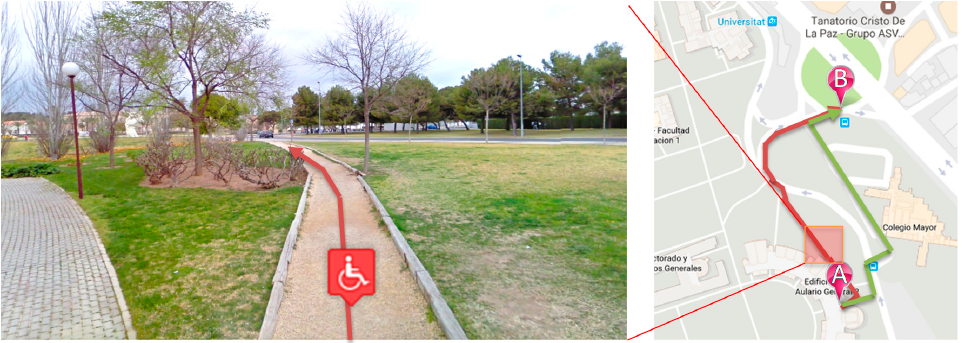
Figure 9. Example 2. Different routes detected due to movement disability.